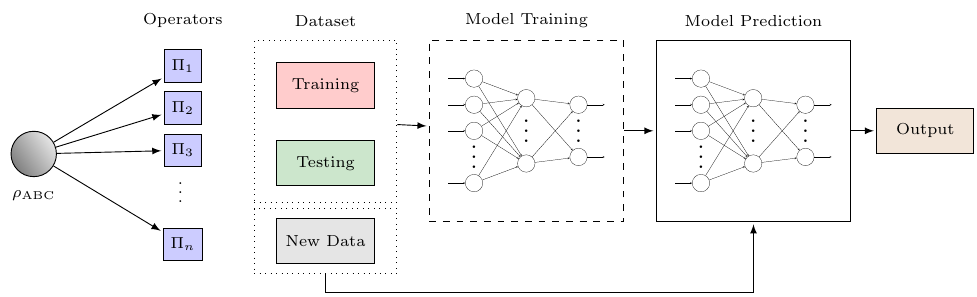
Figure 4. An ANN model for training, testing, and